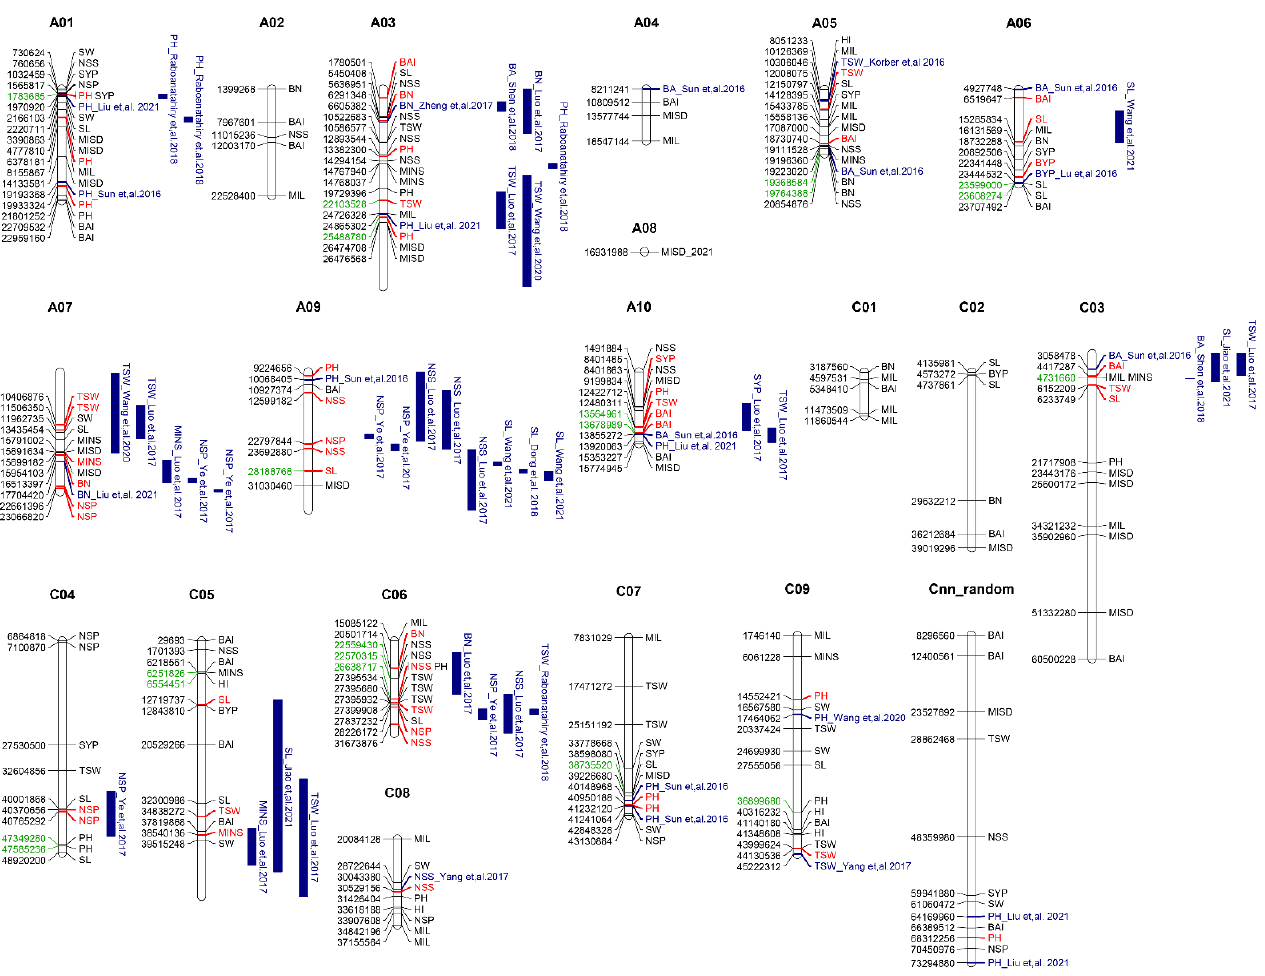
Figure 4. Comparison of related SNPs/QTL localization on the chromosome between current and Figure 4. SNP/QTL localization on the chromosome. The physical positions of stable significant previous reports. The related SNPs/QTL of previous studies are colored blue, and the rest loci are SNPs are colored green and the SNP is labeled in red if it is adjacent to the reported QTL/SNPs. The detected in this study. For the loci in this study, the physical positions of stable significant SNPs are relative SNPs/QTLs of previous studies are colored blue. colored green and the SNP is labeled in red if it is adjacent to the reported